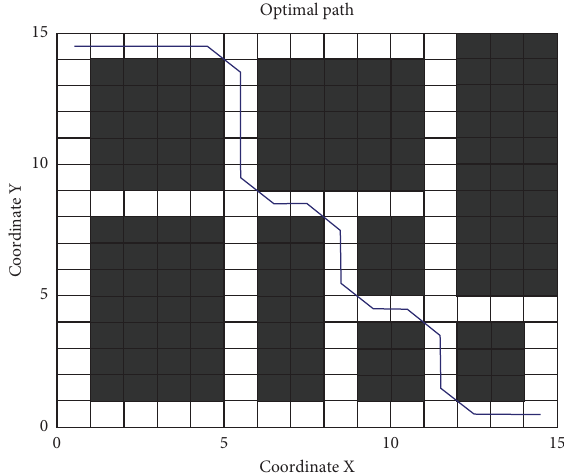
Figure 6: Te optimal path of the ant colony algorithm.